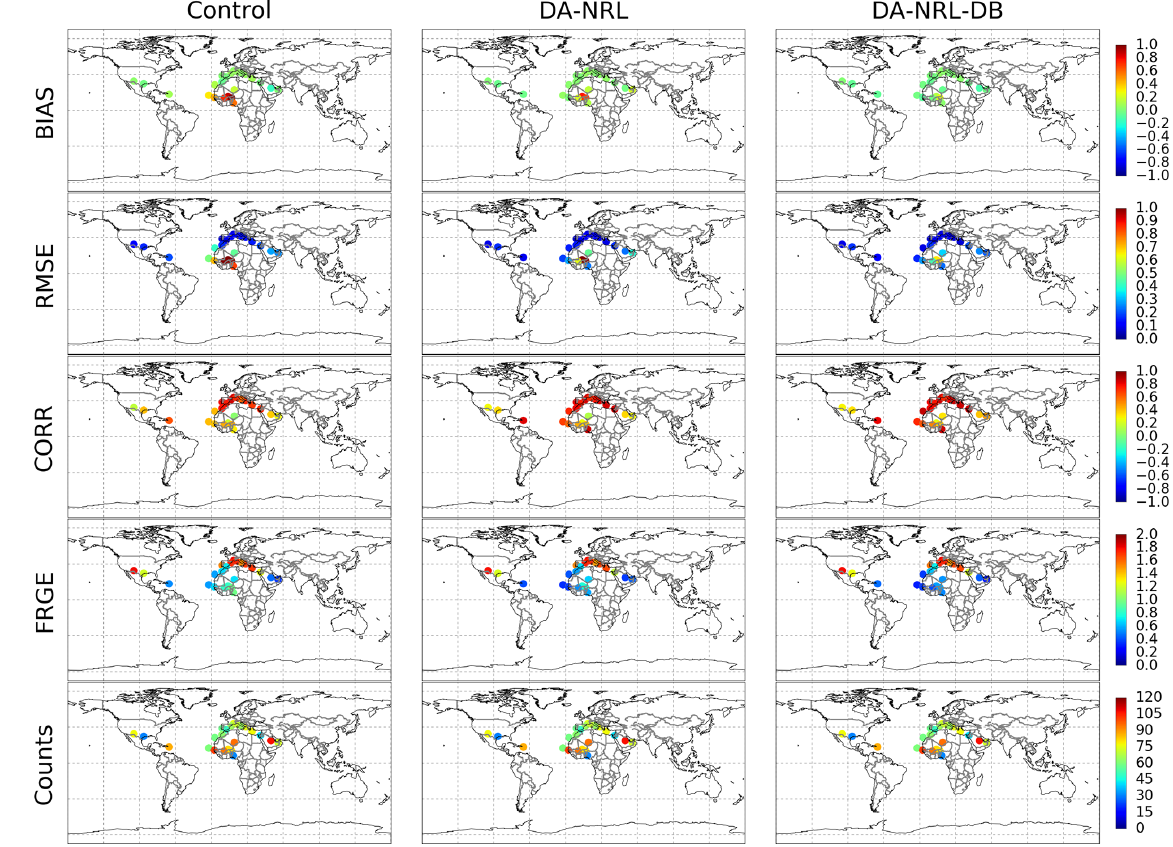
Figure 12. Maps of validation statistics: BIAS, RMSE, CORR, and FRGE for the Control (left), DA-NRL (centre), and DA-NRL-DB (right) experiments calculated against AERONET AOD for a selection of stations providing observations during the study period (May to August 2007). Maps of the observation counts used for validation are shown in the bottom